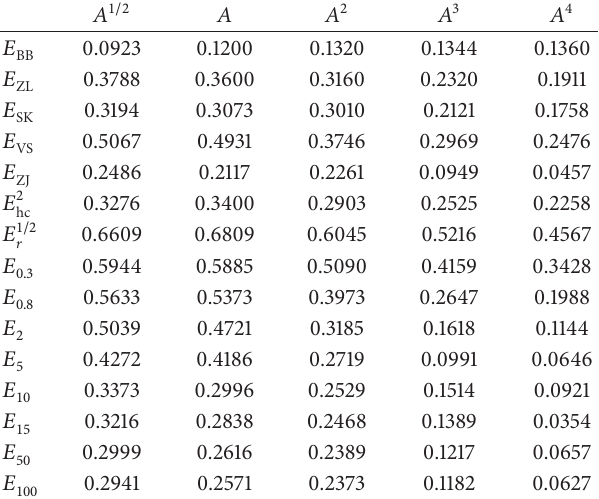
Table 1: Values of the different entropy measures under 𝐴 1/2 ,𝐴 , 𝐴 2 , 𝐴 3 ,𝐴 4